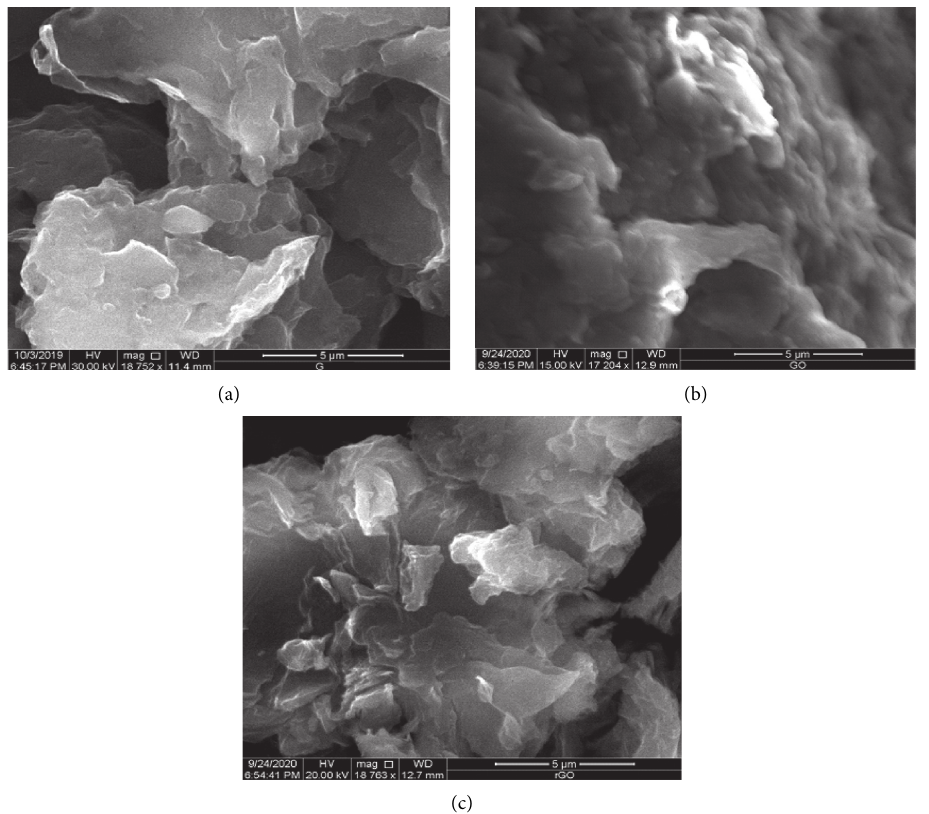
Figure 6: SEM morphology of (a) graphite, (b) GO, and (c)